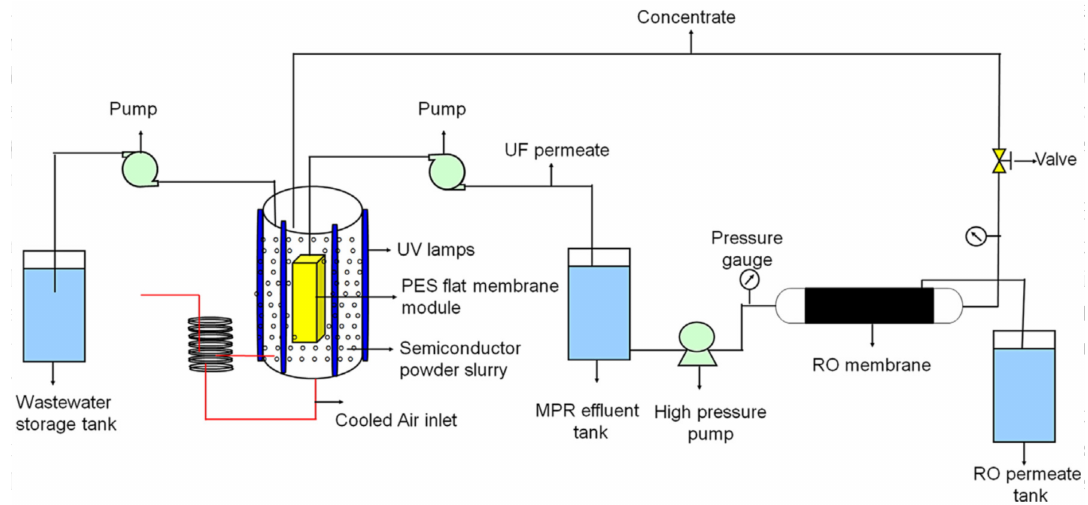
Figure 10. Schematic diagram of the PMR coupled with RO filtration for removal of textile and wood processing industry wastewater.